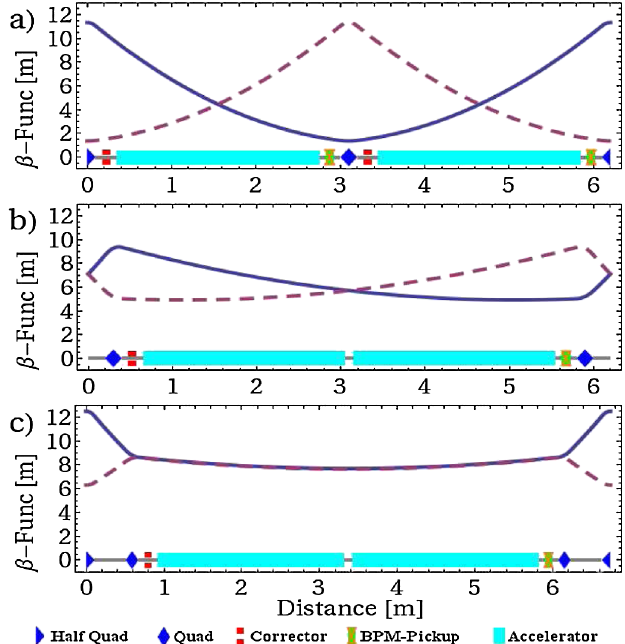
FIG. 5. Sketch of the lattice cells and betatron functions along the cells. (a) FODO. (b) Doublet. (c) Triplet. Strength of quadru- poles is scaled with